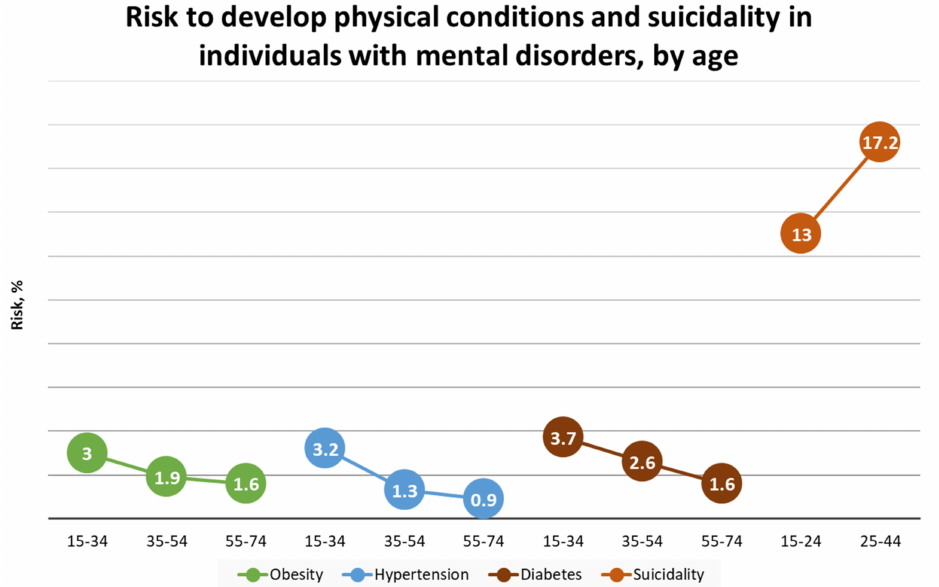
Figure 1. Risk of developing poor physical conditions and death from unnatural causes in individuals with mental disorders by age. Data on obesity, hypertension, and diabetes were extracted from The Health Improvement Network in 2018 in England, comprising 1,051,127 patients. Out of them, 9357 (0.9%) had a diagnosis of severe mental illness (SMI). The rate ratios of the prevalence were calculated between the SMI and all patients in three age groups, i.e., 15–24, 25–54, and 55–74 [17]. The standardized mortality ratio from suicide was calculated using 1,003,906 patients with hospital discharge with depression from a dataset of English national hospital episode statistics, linked with data from death records. The ratios were calculated comparing mortality in people with depression with mortality in the general population of England in two age groups: 15–24 and 25–44 years [18]. Reprinted/adapted with permission from ref. [19]. 2022, Diana M.